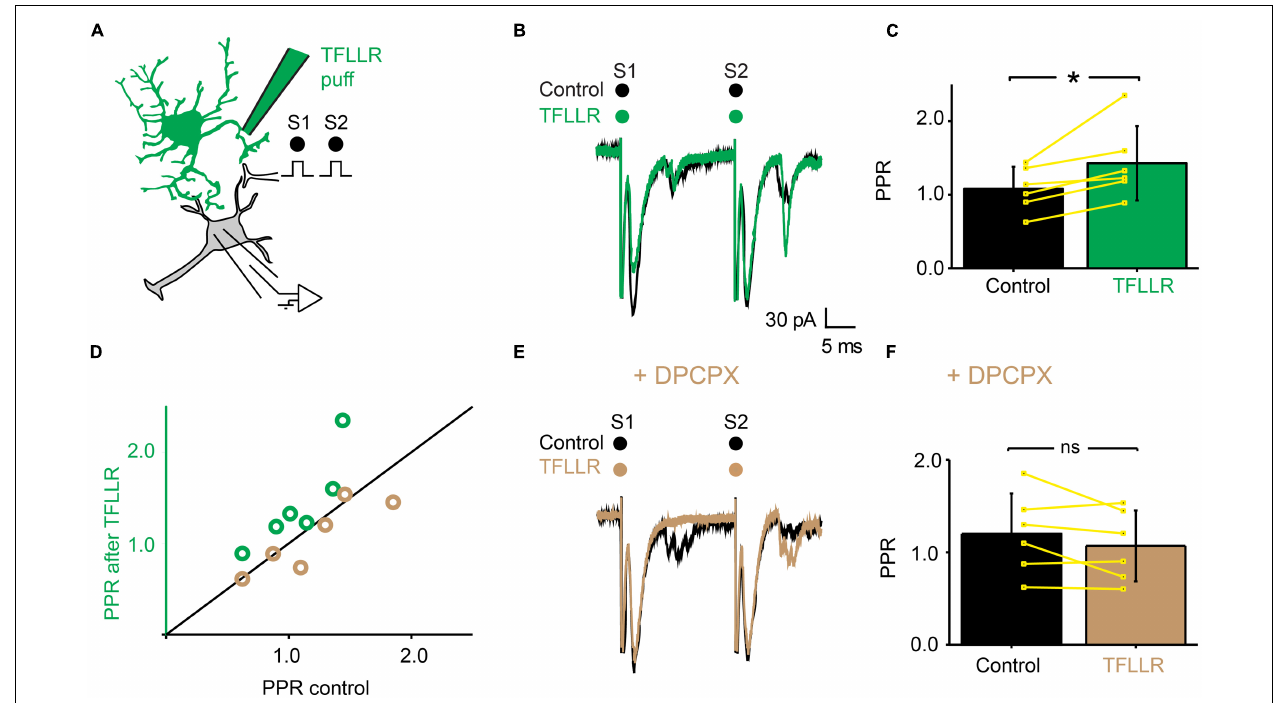
FIGURE 7 |The effects ofTFLLR are blocked by DPCPX. (A) Schema of the principle of the preparation. Ventral horn neuron recorded in whole-cell mode. Synaptic stimulation produced by a bipolar electrode (S1, S2). Puff application of TFLLR. (B) Response of a ventral horn neuron to two stimulations in control conditions (black) and after puffing TFLLR between the stimulation and recording electrode (green). The amplitude of the first EPSC was decreased. (C) Mean values of the PPR before and after puffing